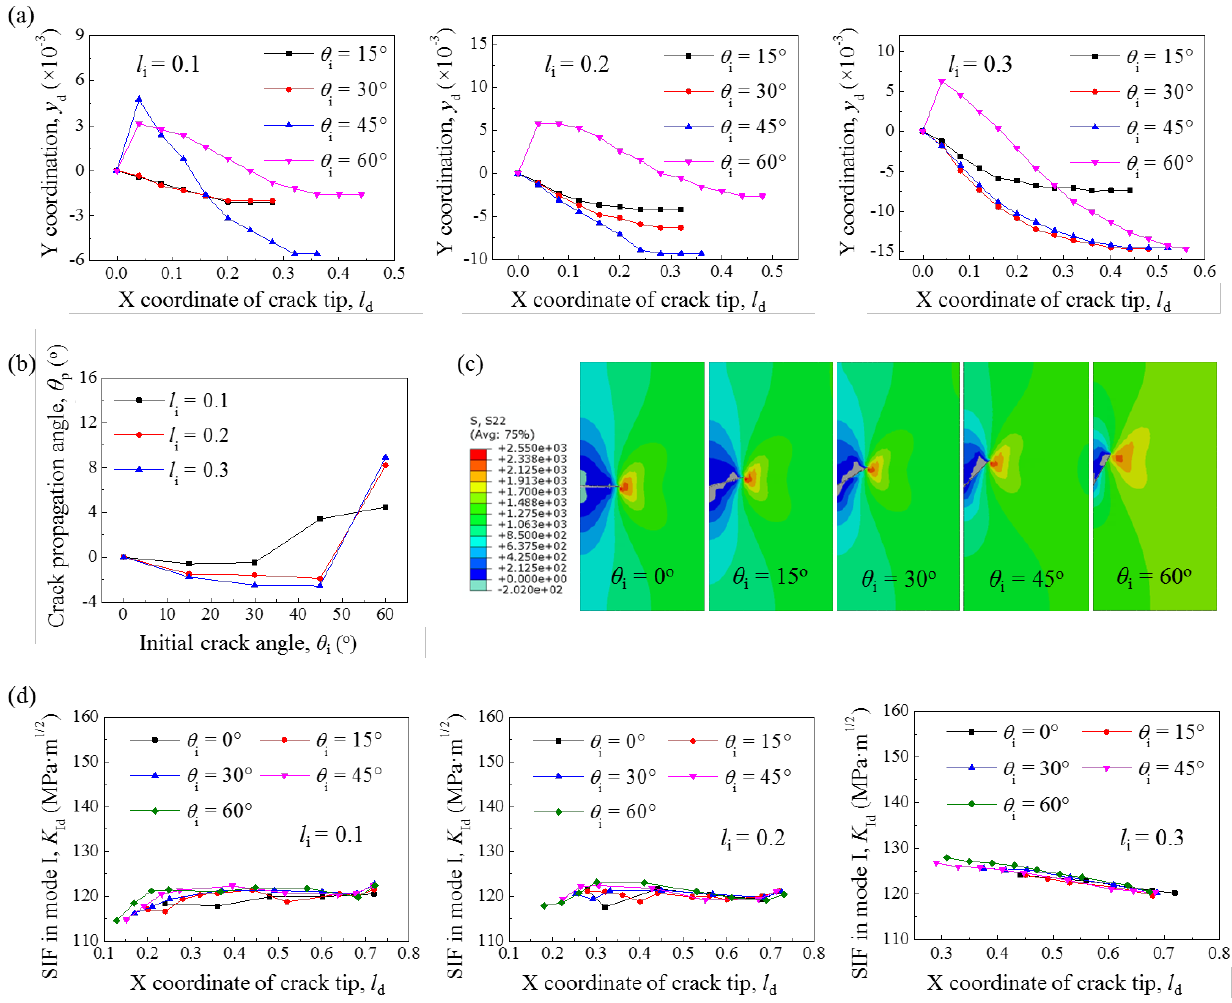
Figure 10. ( a ) Comparison of crack paths when the initial crack angle ranges from 15° to 60° with the initial crack lengths 0.1, 0.2 and 0.3. ( b ) Comparison of crack propagation angles when the initial crack angle ranges from 0° to 60°. ( c ) Comparison of stress contours when the crack with l d = 0.1 starts to propagate with the initial crack angles ranging from 0° to 60° and ( d ) K Id with initial crack lengths ranging from 0.1 to 0.3.